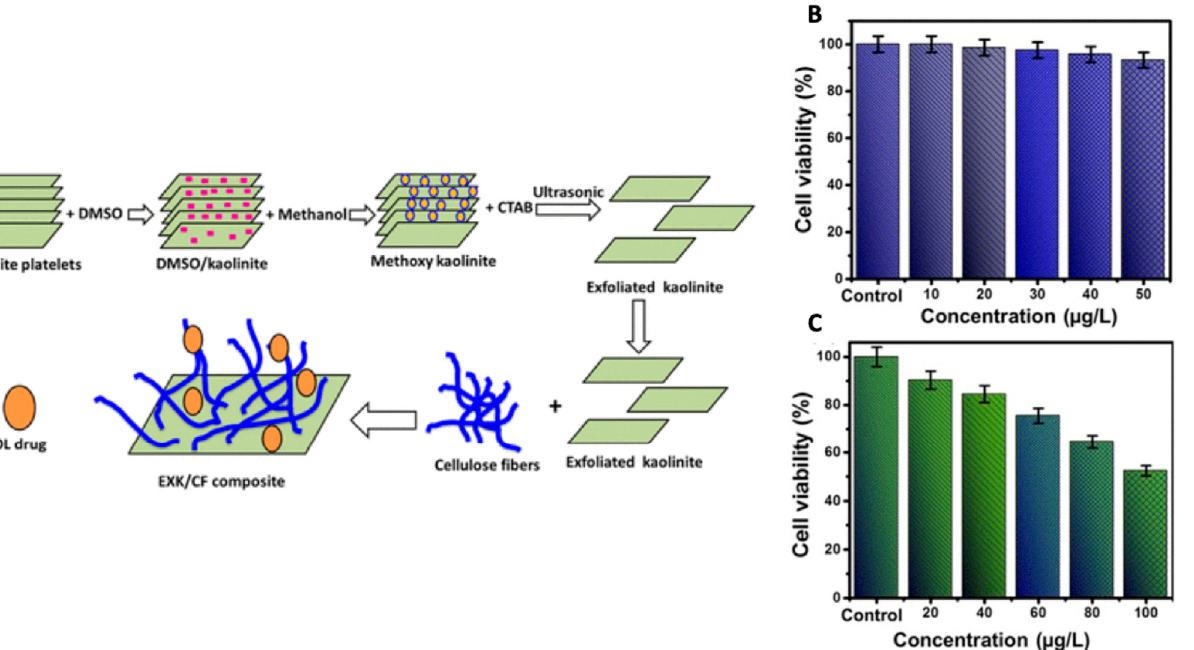
Figure 8. Schematic representation of the synthesis steps of the composite EXK/CF and its subsequent loading with the drug OL ( A ). Cell viability of colorectal fibroblast cells (CCD-18Co) after incubation with the composite EXK/CF ( B ) and of colorectal cancer cells (HCT116) after incubation with the composite EXK/CF loaded with OL ( C ). Reproduced from ref. [123].